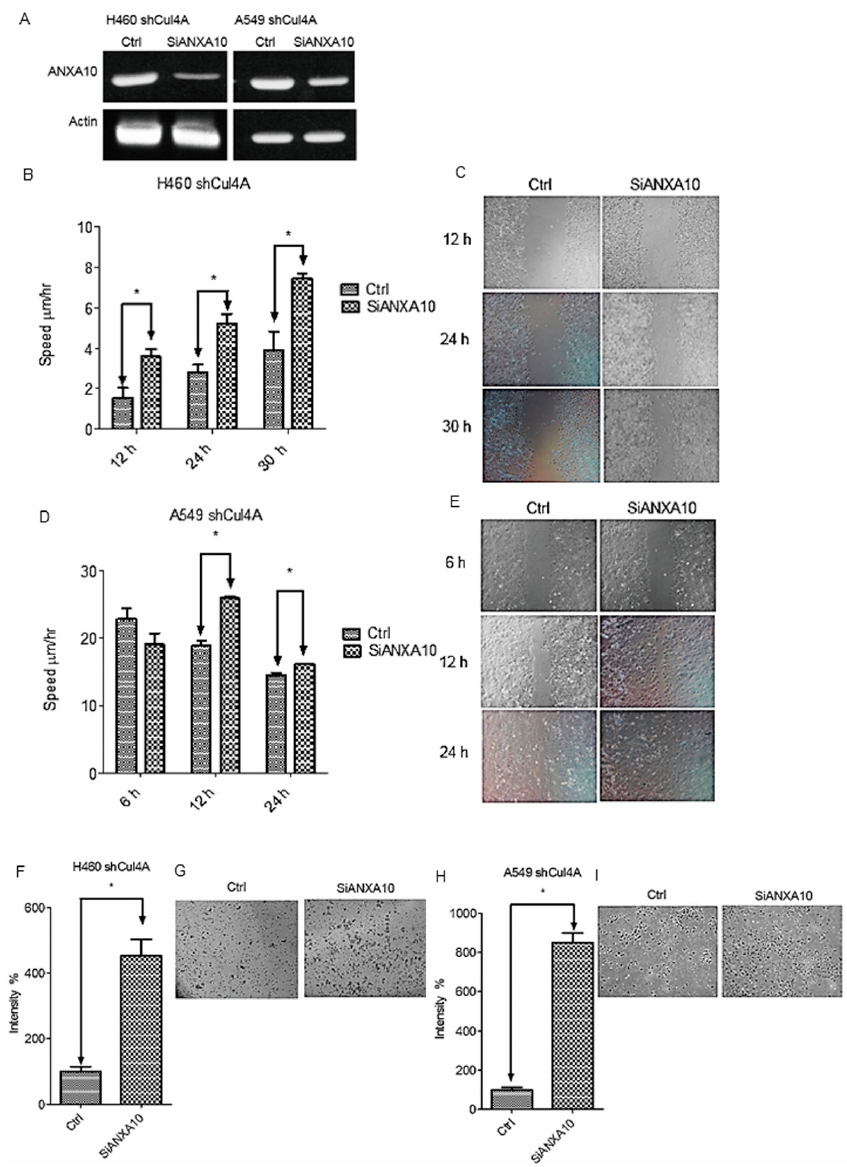
Figure 4. ANXA10 knockdown restores cell migration and invasion in Cul4A knockdown cells. ( A ) RT-PCR of ANXA10 in H460 (H460 shCul4A) and A549 (A549 shCul4A) Cul4A shRNA transfected stable lung cancer cells or transfected with control siRNA (ctrl) and ANXA10 siRNA (siANXA10). ( B , C ) Cell migration assay of H460 shCul4A stable lung cancer cells. ( D , E ) Cell migration assay of A549 shCul4A stable lung cancer cells. ( F , G ) Cell invasion assay of H460 shCul4A stable lung cancer cells. ( H , I ) Cell migration assay of A549 shCul4A stable lung cancer cells. Experiments were performed in triplicate. Data points represent the average migration speed or cell intensity ± standard deviation. * denotes p < 0.05. h: hours.